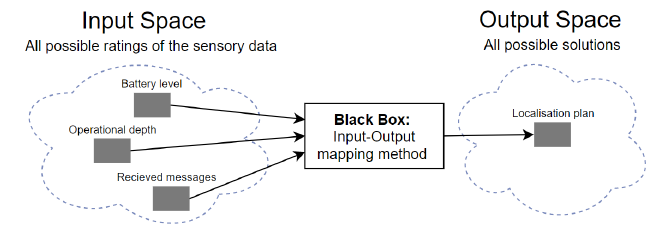
Figure 5. An example of input-output mapping for the localisation problem: “Given three variable inputs what the localisation plan should